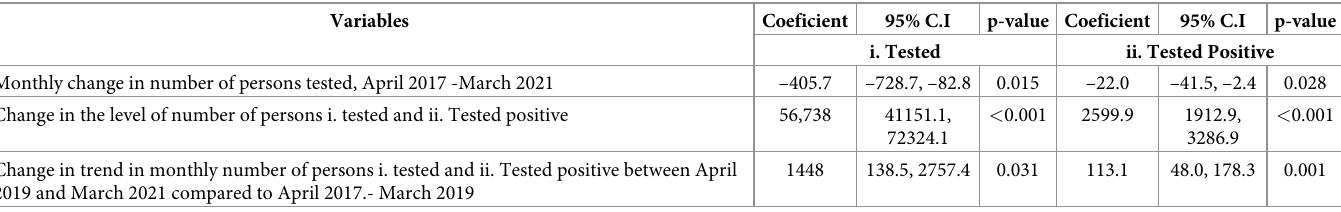
Table 4. Results from segmented regression analysis on uptake of HIV testing.